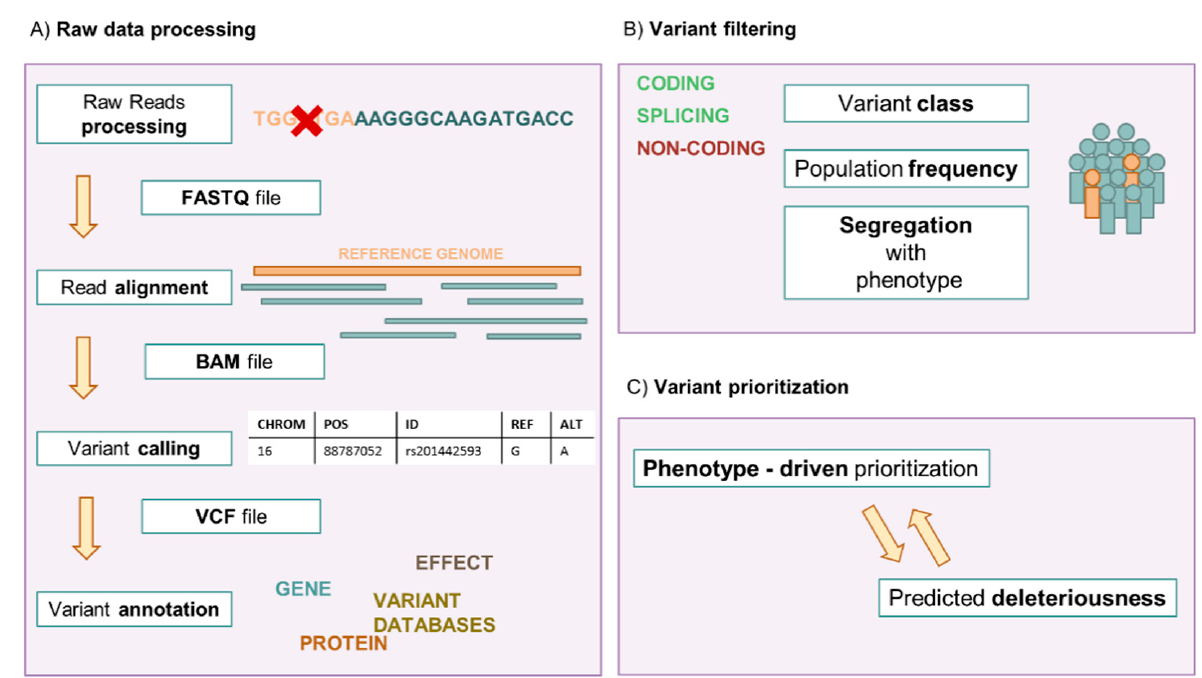
Figure 2. NGS bioinformatic workflow. ( A ) The sequencing reaction generates millions of short reads (40 to 400 nucleotides long). The reads are processed by marking duplicates and barcode and adapter sequences. Individual reads are retained in a FASTQ file. They are then aligned to the reference genome, generating a BAM file. Variants are identified (called) from nucleotide positions differing from the reference sequence, and gathered in a VCF file, consisting of a list of genomic coordinates with the reference sequences, the putative variants and quality scores. These variants are then annotated with information gathered from various databases, on variant frequency, gene(s) involved, gene products, predicted deleteriousness, reported pathogenicity or benignity. They are then manually analyzed by filtering ( B ) and prioritization ( C ). Variants with no impact on gene products, high frequency in the general population and not segregating with the phenotype are ruled out. The remaining variants are prioritized by various criteria, for example by potential relation to the phenotype or predicted